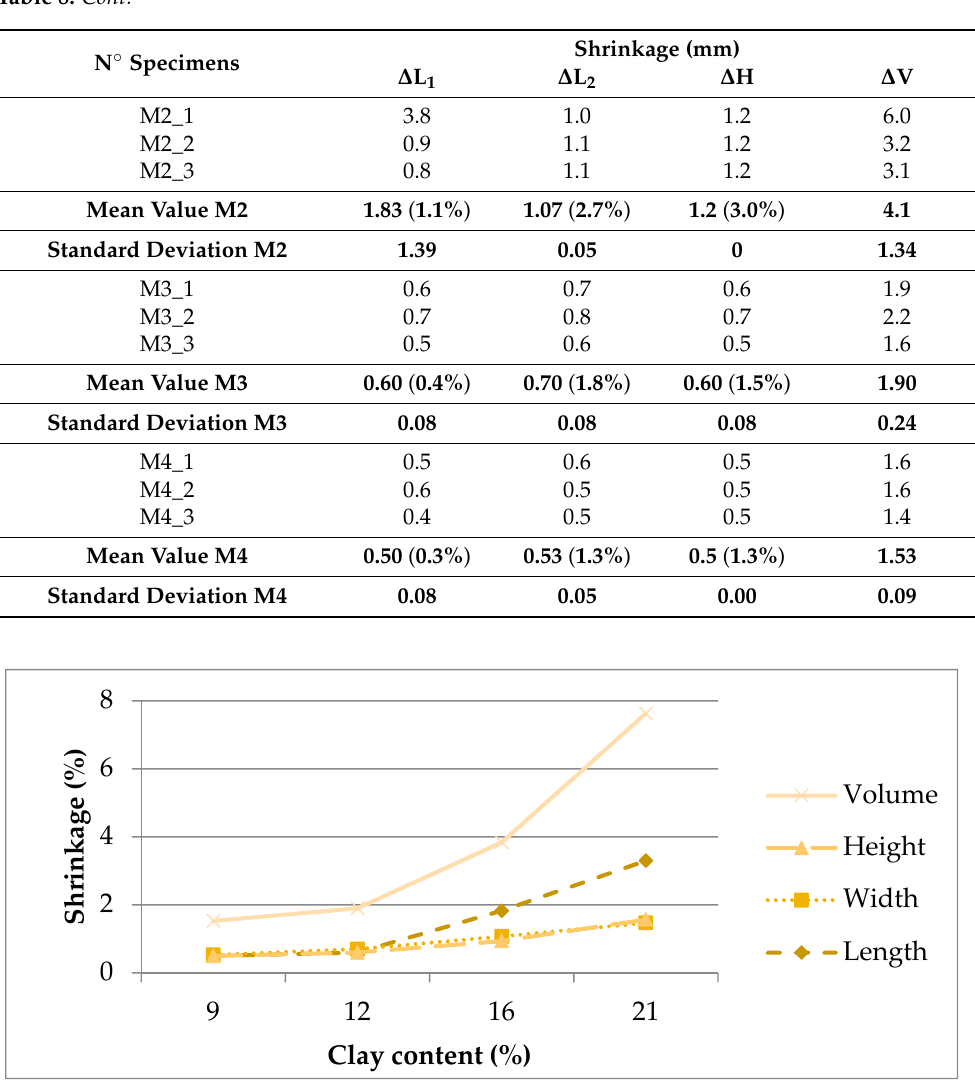
Figure 12. Linear and volumetric average shrinkage for M1–M4 mortars vs. the clay content.